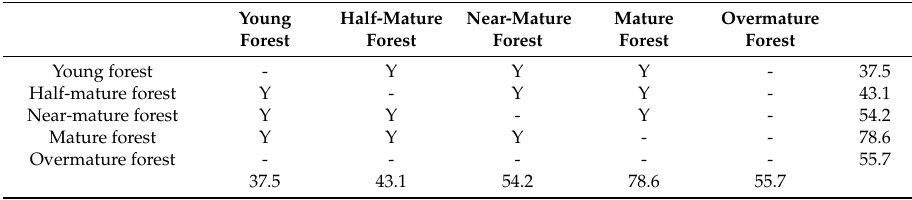
Table A3. Tukey’s HSD test for age group factor (Y means the testing is significant at the 0.05 level, and N represents an insignificant di ff